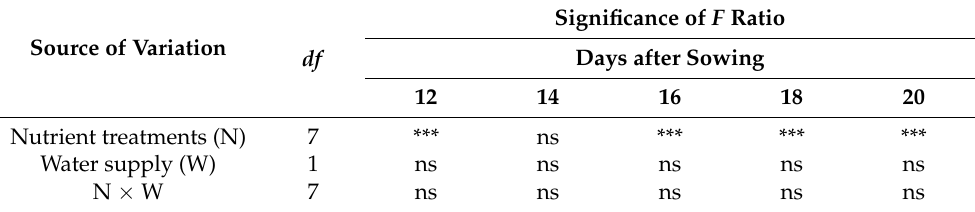
Table 6. Analysis of variance (ANOVA) results for shoot dry weight (DW) at days of 12, 14, 16, 18 and